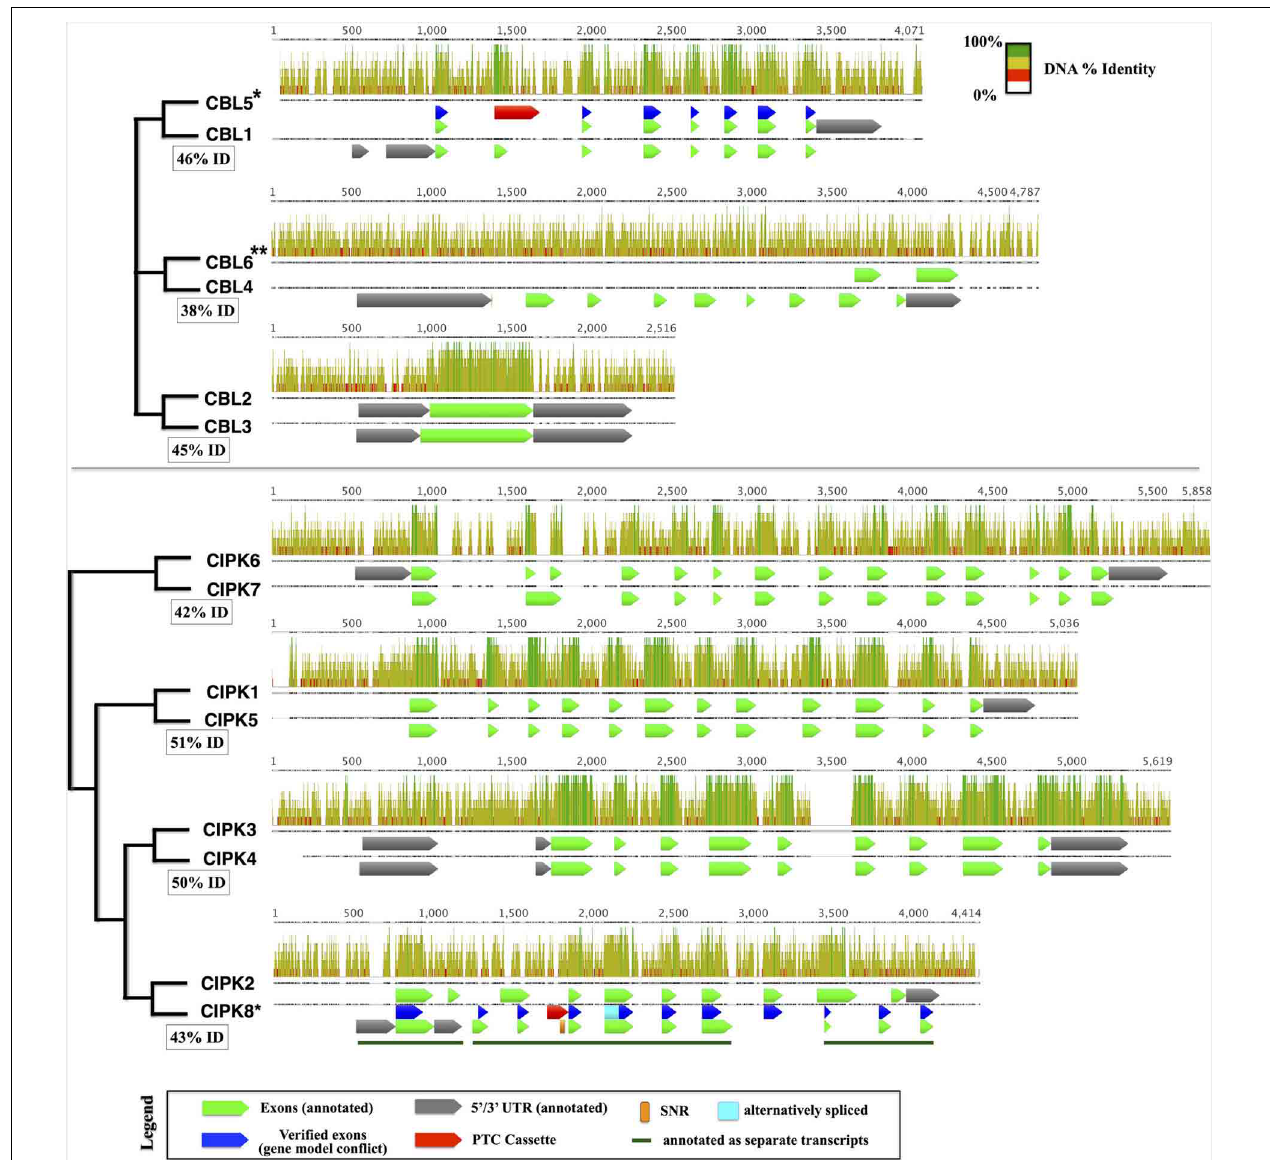
experimentally inferred gene model did not match the annotation, verified exons (blue), alternatively spliced regions (cyan), and premature termination cassettes (PTCs; red) are shown for comparison. CIPK8 , which was annotated incorrectly as three separate transcripts, contains a long single nucleotide repeat (SNR) comprised of 31 thymidine (T) residues and described further in the main text. Sequences and associated annotations were extracted from the Physcomitrella genome v1.6 starting from 500 nucleotides (nt) upstream of the annotated 5 (cid:4) UTR (750nt upstream CDS for genes lacking 5 (cid:4) UTR annotations) to 250nt downstream of the annotated 5 (cid:4) UTR (500nt downstream the CDS) were extracted. Pairwise loci were aligned using MAFFT. Although PpCBL6 has annotated exons, there is no experimental evidence that any part of this locus in